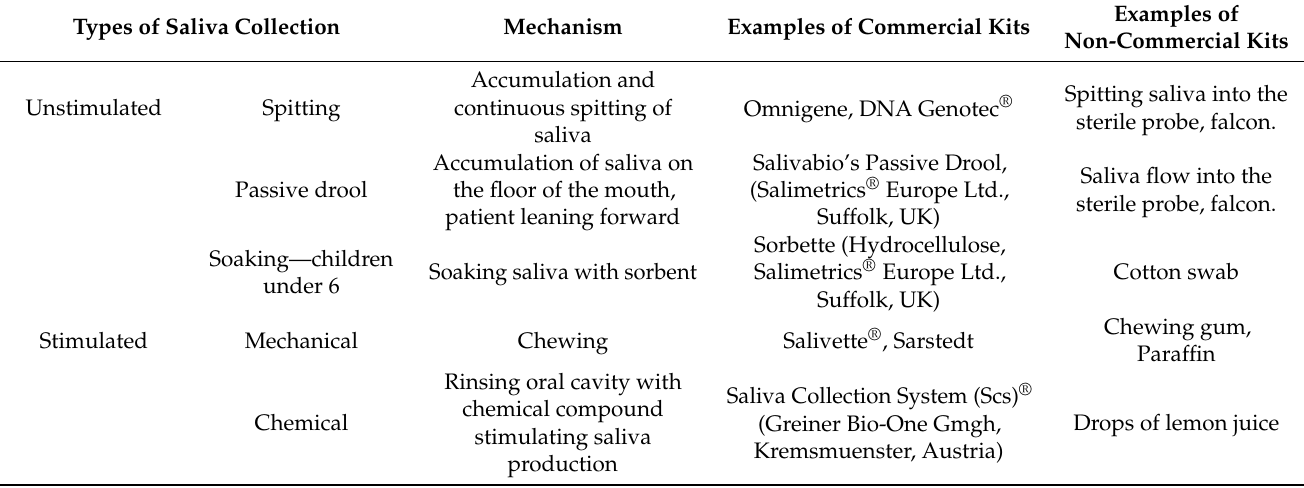
Table 1. The description of stimulated and unstimulated whole saliva commercial and non-commercial collection procedures and kits. Types of Saliva